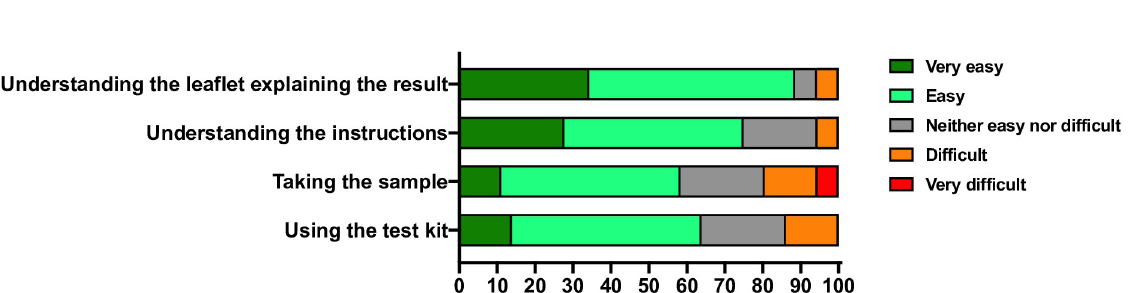
Fig 6. Ease of use. Summary of ease of use questionnaire. Participant ease of use responses to the indicated categories were expressed as a percentage of responses.